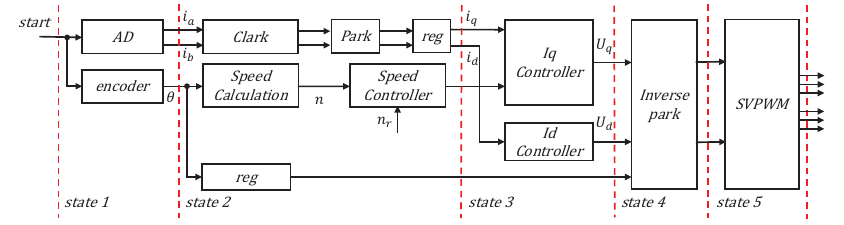
Figure 18. FOC algorithm control based on FPGA.